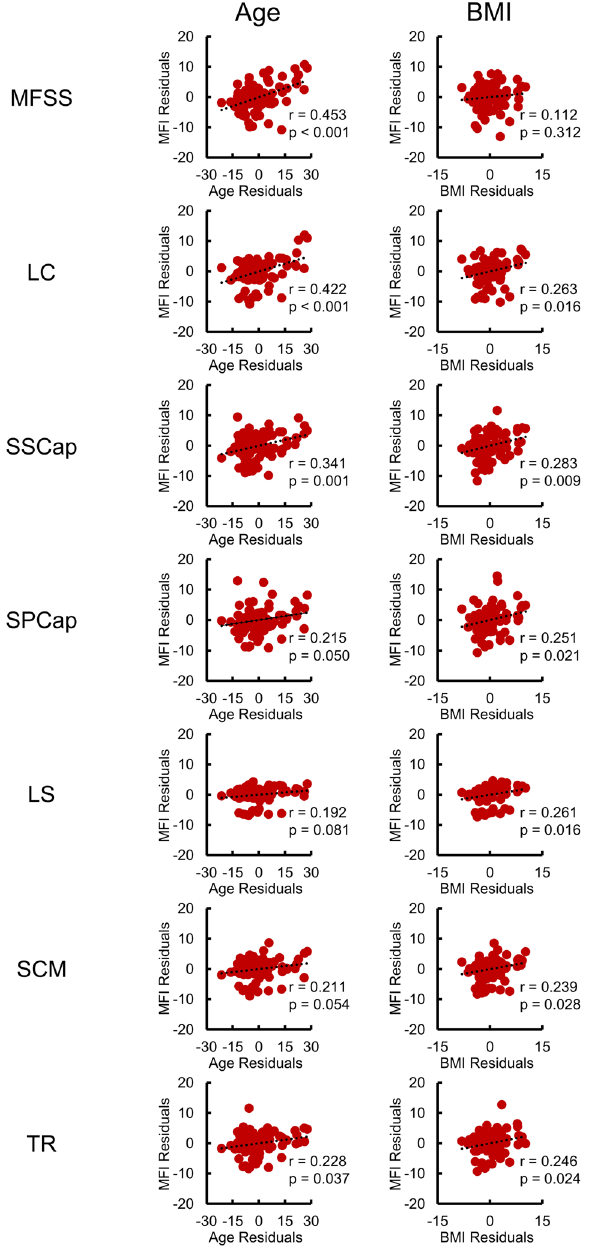
Figure 6. Relationship between muscle fat infiltration (MFI), age, and body mass index (BMI) across the muscle groups. Partial correlations (Pearson’s r) were performed to identify linear relationships between MFI and age or MFI and BMI in 84 participants from the first time point (< 2 weeks following a motor vehicle collision, 61 females, 23 males, age = 34.2 ± 10.7 years) after controlling for sex and BMI or sex and age, respectively. The left and right MFI measures for each muscle group were averaged for this analysis. For MFI and age, the residuals of MFI are plotted on the residuals of age after controlling for sex and BMI. For MFI and BMI, the residuals of MFI are plotted on the residuals of BMI after controlling for sex and age. Moderate correlations (r > 0.300) were only present between MFI and age for the deep cervical muscles (MFSS, LC, and